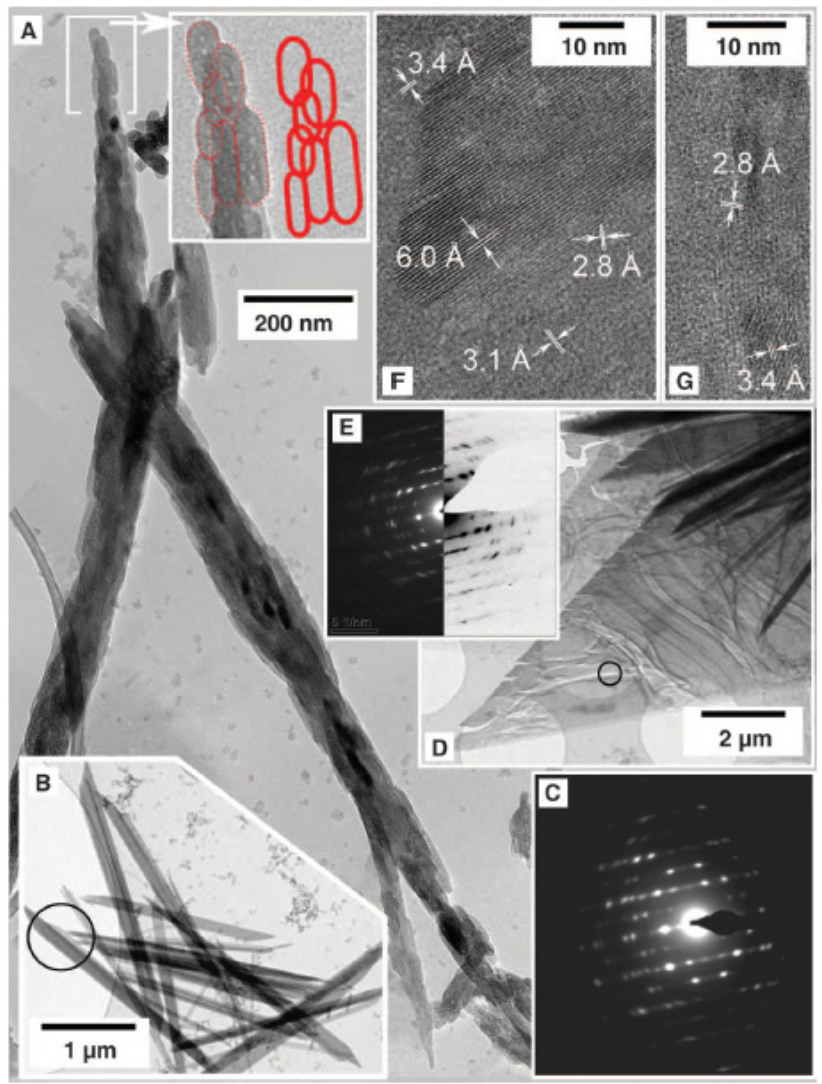
Figure 9. Gypsum crystallization. ( A ) A large, oriented aggregate of bassanite nanorods. ( B–E ) Gypsum crystals: C corresponds to the area marked in B, E corresponds to the area marked in D. ( F , G ) are high-resolution images of D for characteristic distances of bassanite (6.0, 3.4, and 3.1 Å) and gypsum (3.1 and 2.8 Å). Figure from Van Driessche et al. (2012) [11].